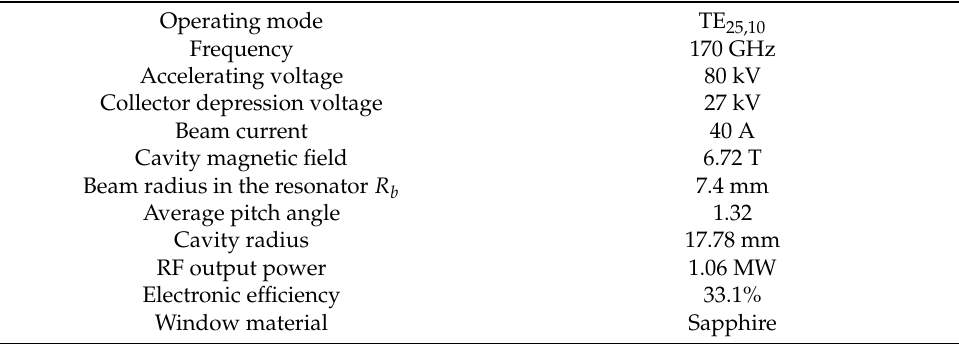
Table 1. The design parameters of the 170 GHz gyrotron.